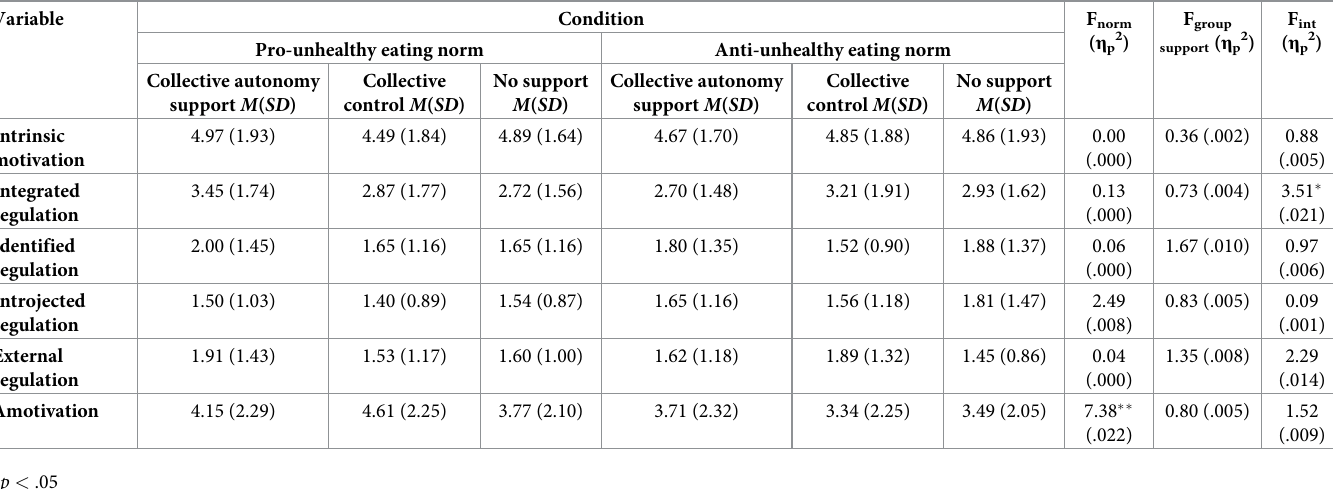
Table 2. Comparisons of motivations to eat unhealthy food across